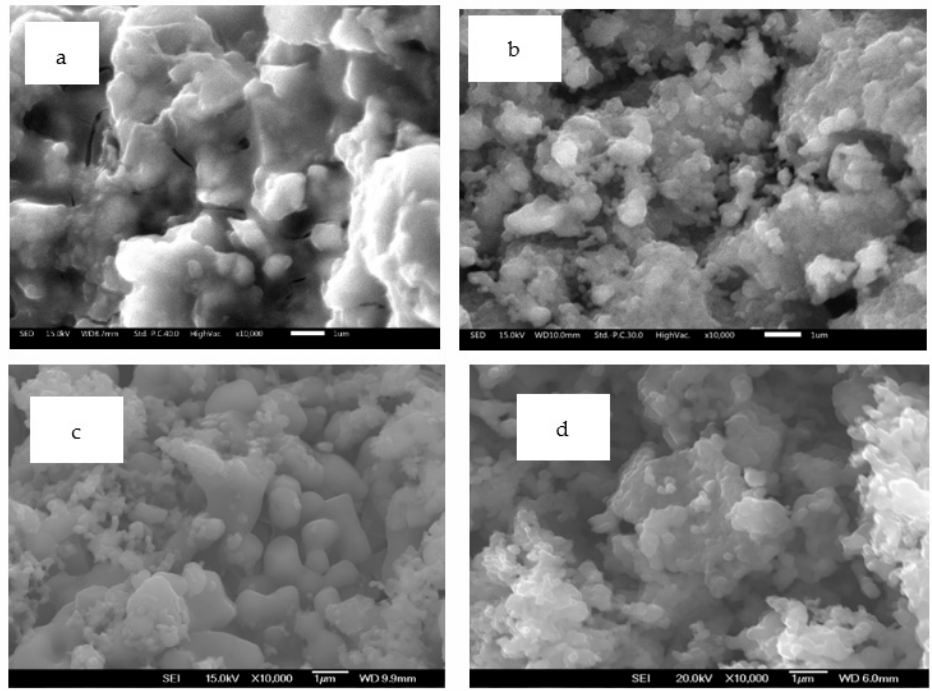
Figure 7. SEM images of sorbent material with ×10,000 magnification for: ( a ) fresh sorbent material, ( b ) without contaminants, ( c ) combined NH 3 and H 2 S, ( d ) combined HCl, NH 3 , and H 2 S.